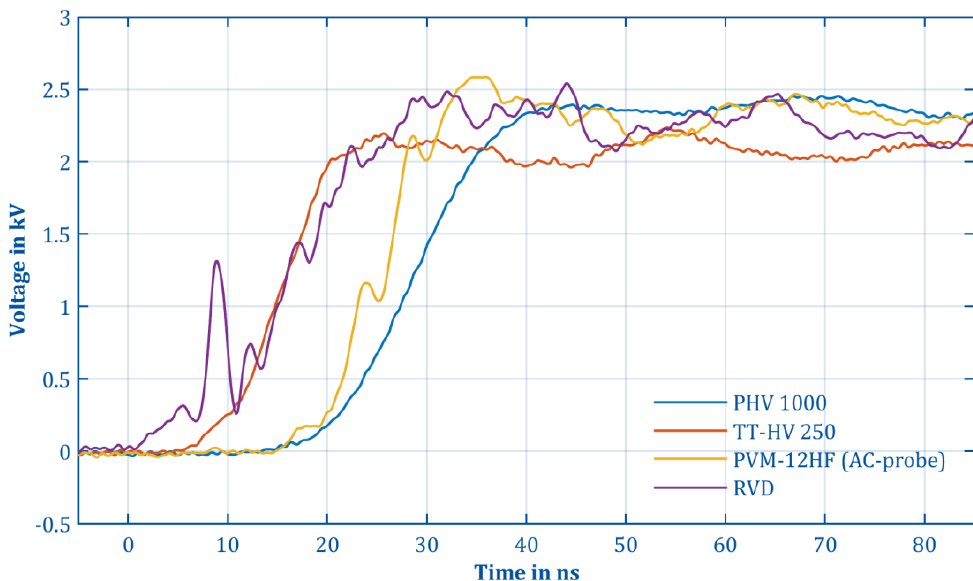
Figure 13. Measurement of a high-voltage transient with the resistive voltage divider and the three commercially available high-voltage probes from Table 3.